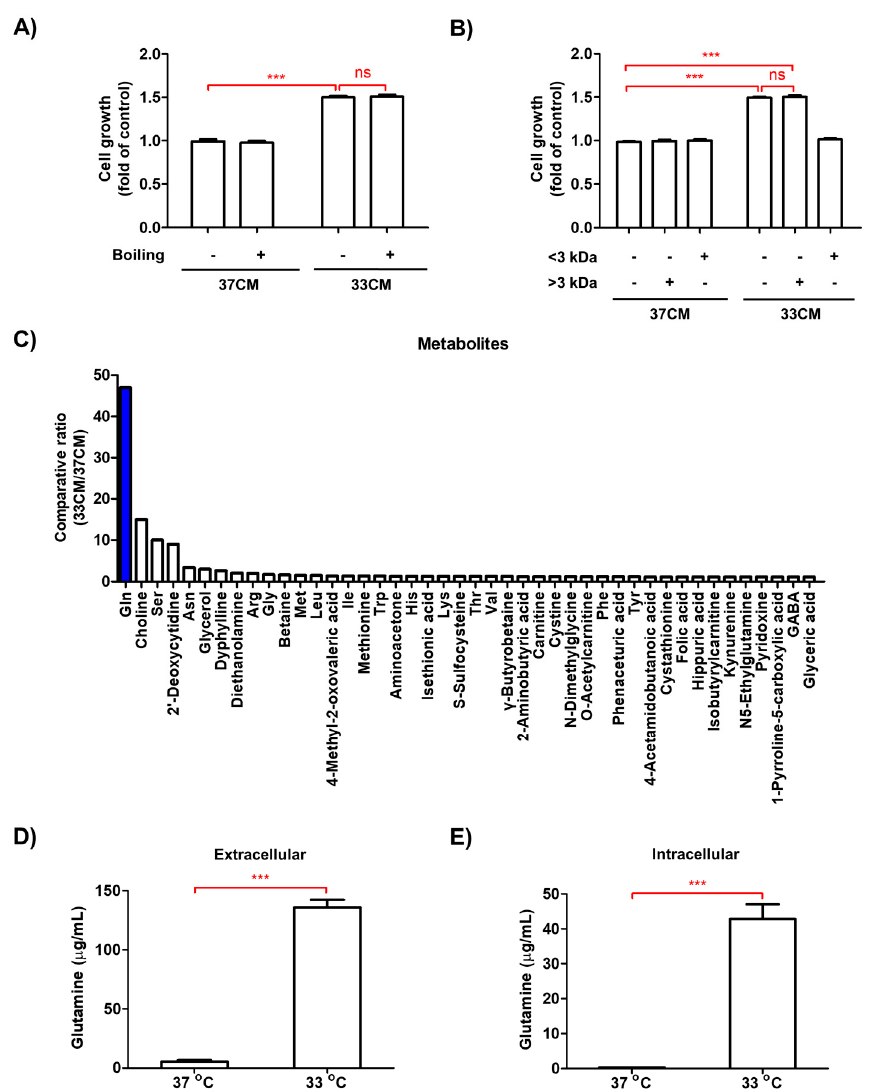
Figure 4. Glutamine production was elevated in macrophages exposed to low temperature. ( A ) CM from RAW264.7 cells was boiled for 10 min. The growth of LLC cells in the presence of RAW264.7 cell CM that was either boiled or untreated was measured by MTT assay. ( B ) CM from RAW264.7 cells was fractionated using a 3 kDa cut-off filter. LLC cells were incubated with RAW264.7 CM size fractionated at < 3 kDa or > 3 kDa, or with whole CM. The growth of LLC cells was examined using an MTT assay. ( C ) Metabolite levels in RAW264.7 CM were measured by CE-TOFMS. The ratio of metabolites in 33CM/37CM is presented as the average value. ( D , E ) Glutamine levels in CM ( D ) and cell lysates ( E ) of RAW264.7 cells were measured using HPLC analysis. Data are expressed as the mean ± SD. *** p < 0.001 compared to the control (37 °C). ns means no significance.